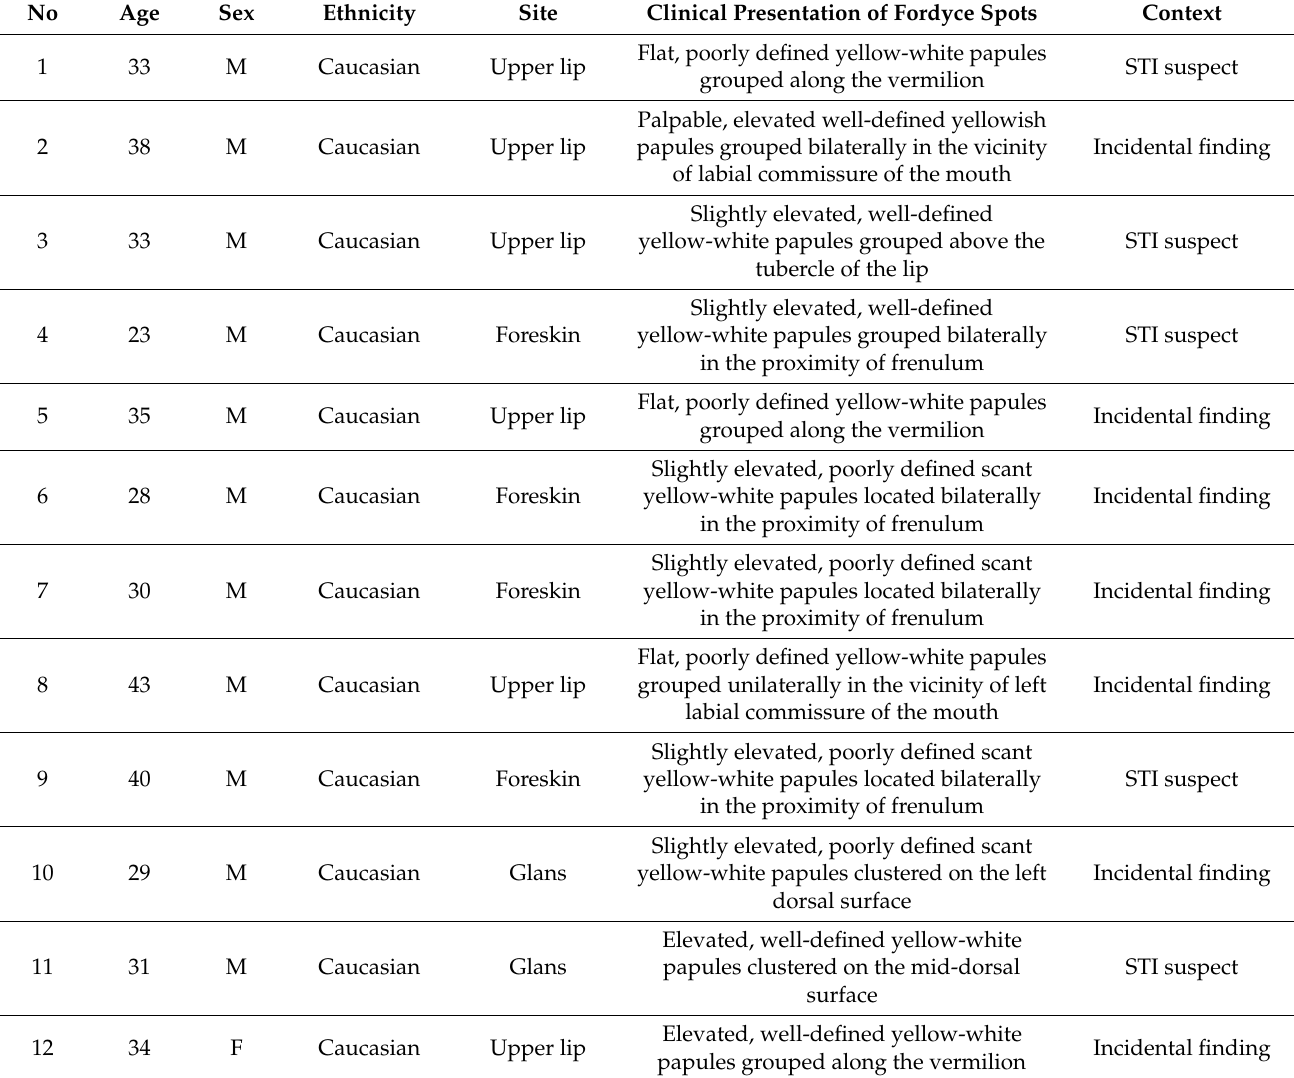
Table 1. Clinical and demographic characteristics of patients with Fordyce